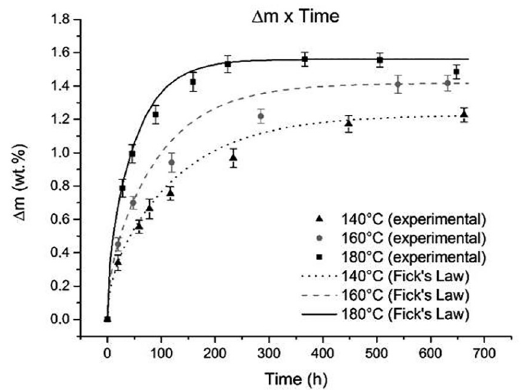
Figure 1: Oil uptake vs aging time for three temperature conditions. The lines correspond to theoretical values calculated by Fick’s Law equations.